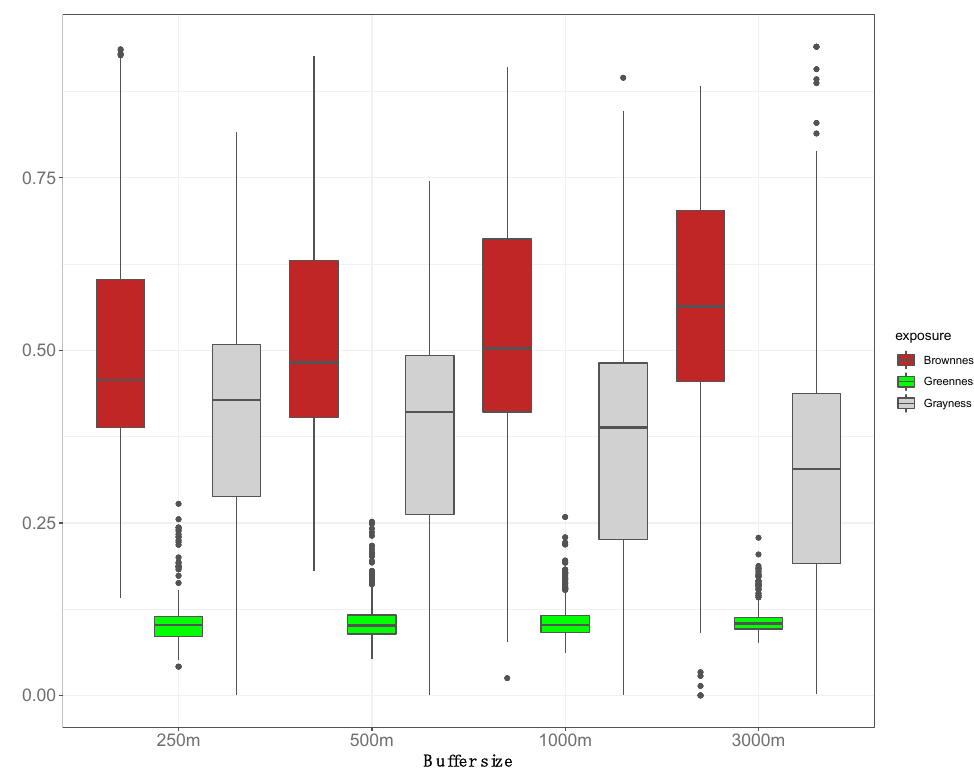
Figure 2. Boxplots for the distribution of brownness, greenness and grayness values summarized across different buffer sizes (e.g., 250, 500, 100, 3000 m) around participants homes. Greenness was measured with NDVI scores and brownness as the remaining surface area after subtracting the fractions of green surface and impervious (gray) surface from the total area of the buffer. The amount of impervious surface was obtained from the National Land Cover Database (NLCD) developed by the Multi-Resolution Land Characteristics (MRLC) Consortium (www.mrlc.gov).